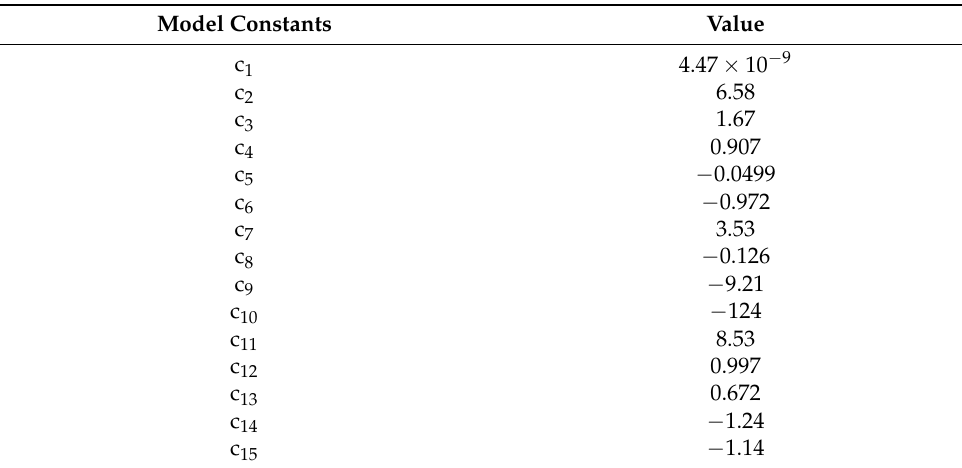
Figure 8. Comparison of predicted and actual ignition delay. Table 2. Tuning constants for the physics-based SOC